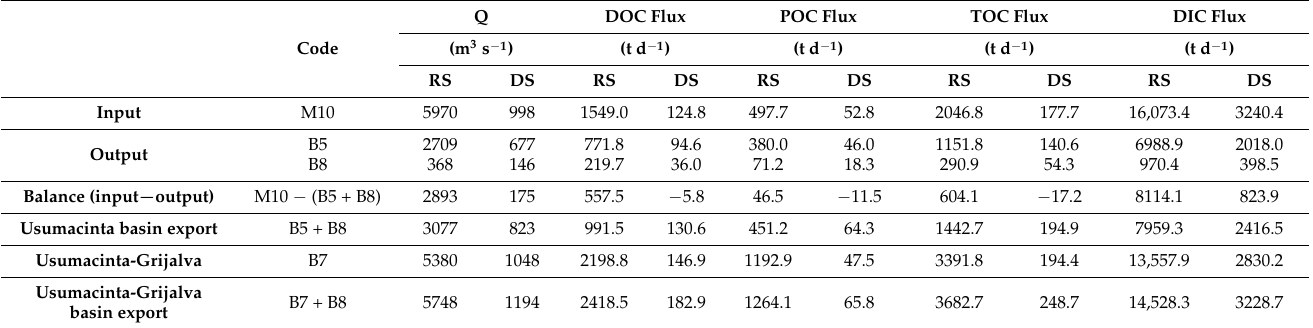
Table 2. Balance of water discharge (Q) and C fluxes in the Usumacinta River basin and the total C export to the Gulf of Mexico in the rainy (RS) and dry (DS) seasons. (See Figure 1 and Table S1 for the detailed locations of the sampling